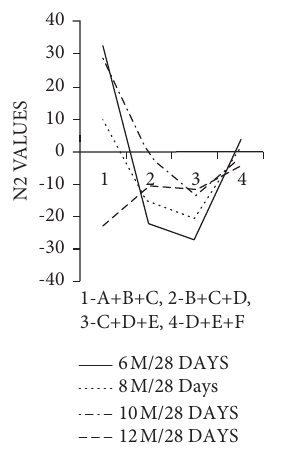
Figure 11: N2 values with increasing composition combinations from A to F (28 days’